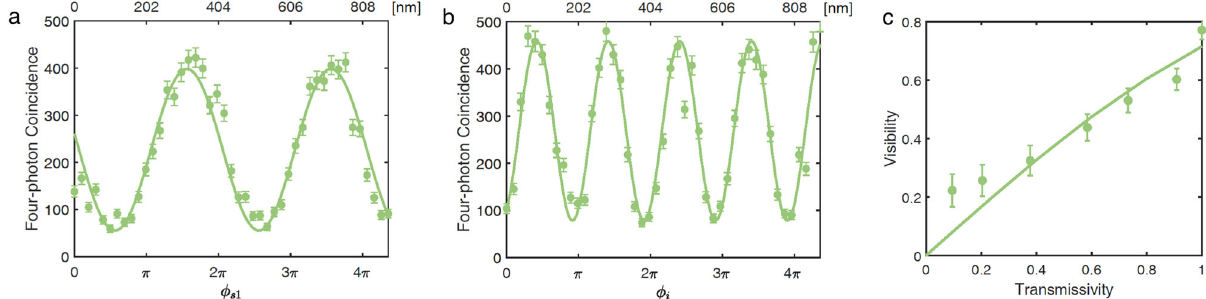
Fig. 3 | Results of four-fold coincidence counts for multiphoton frustrated interference. a The horizontal axis represents the position of M3 ( ϕ s 1 ). The inter- ference pattern of frustrated four-photon interference has visibility of 75.47%±2.99% and a period of 403.5 nm. The green line is the fi tting curve. b The horizontal axis represents the position of M1 ( ϕ i ). The interference pattern has visibility of 74.26%±2.79% and a period of 200.9 nm. The errors of visibilities are